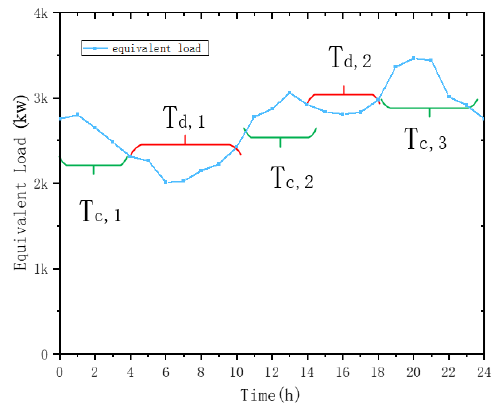
Figure 3. The strategy of charging and discharging.